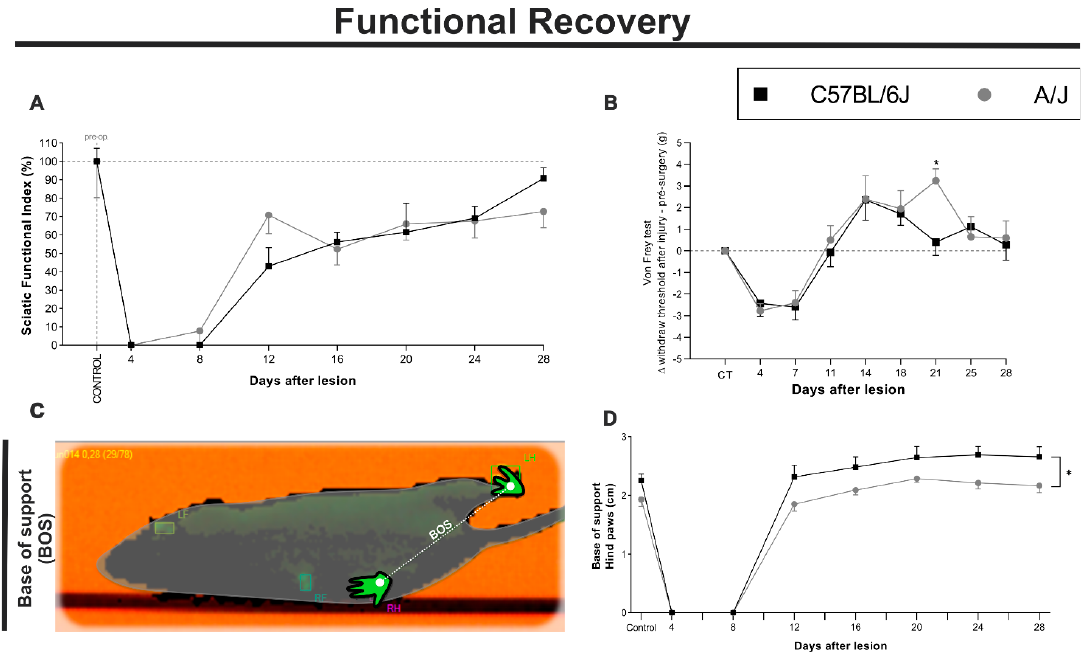
Figure 9. Functional recovery of C57BL/6J and A/J animals after crushing of the sciatic nerve through the sciatic functional index—SFI and the BOS (CatWalk system, motor analysis) in addition to the nociceptive threshold (von Frey system, sensory analysis). ( A ) SFI was analyzed in the C57BL/6J and A/J strains for 4 weeks (28 days). Mice from both strains fully recovered their gait, obtaining values similar to those found in the preoperative evaluation. No significant differences could be obtained. ( B ) The nociceptive threshold was analyzed in the C57BL/6J and A/J strains for 4 weeks (28 days) at intervals of 3 to 4 days. It was observed that the animals in both strains recovered sensitivity, obtaining values similar to those found in the preoperative evaluation, and that when the nociceptive threshold was compared between both strains, A/J mice presented a peak in hypersensitivity on the 21st day of recovery (21). ( C ) Schematic example of the BOS measurement collected by the CatWalk system—walking track test. The base of support (BOS) was used as an indirect measurement of proprioceptive recovery after sciatic nerve injury. ( D ) BOS comparison between the strains showed a greater compensation for the C57BL/6J mice when compared with the A/J, depicting a chronic insufficiency The SFI is expressed as a percentage of the preoperative value; the mean value of the nociceptive threshold is proportional to the control group; the BOS is measured by the CatWalk system distance unit n = 5 per group/day for each strain. Mean ± SEM; * p <